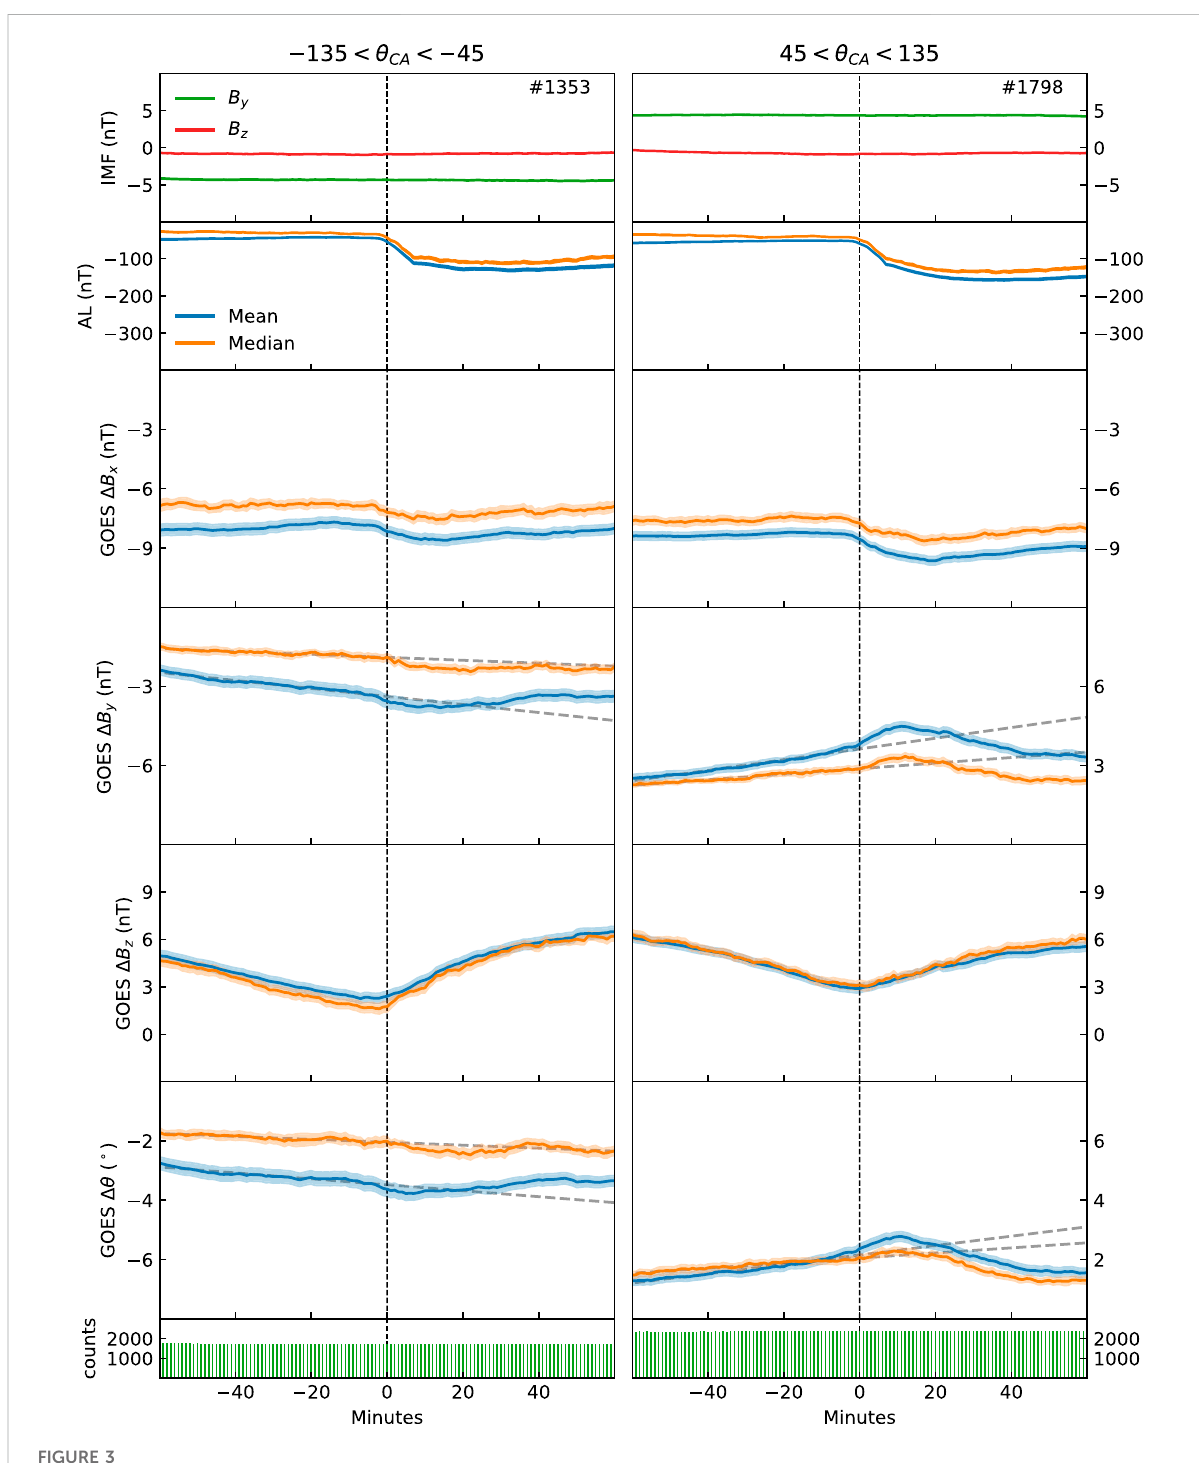
FIGURE 3 Superposed epoch analysis relative to substorm onset as identi fi ed by the O&G onset list, format as Figure 1.